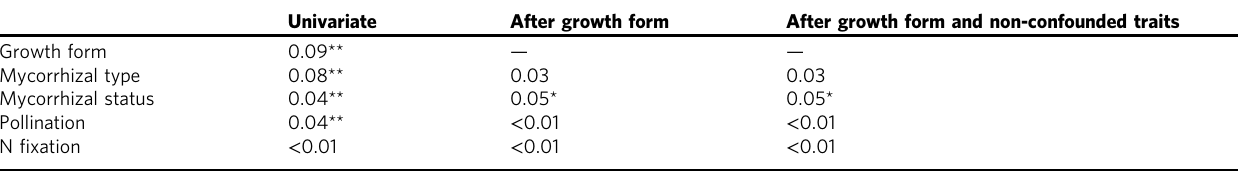
Table 3 Power of mutualist traits and growth form to predict the climatic niche of 131 plant MOTUs in northern high-atitude permafrost samples 15